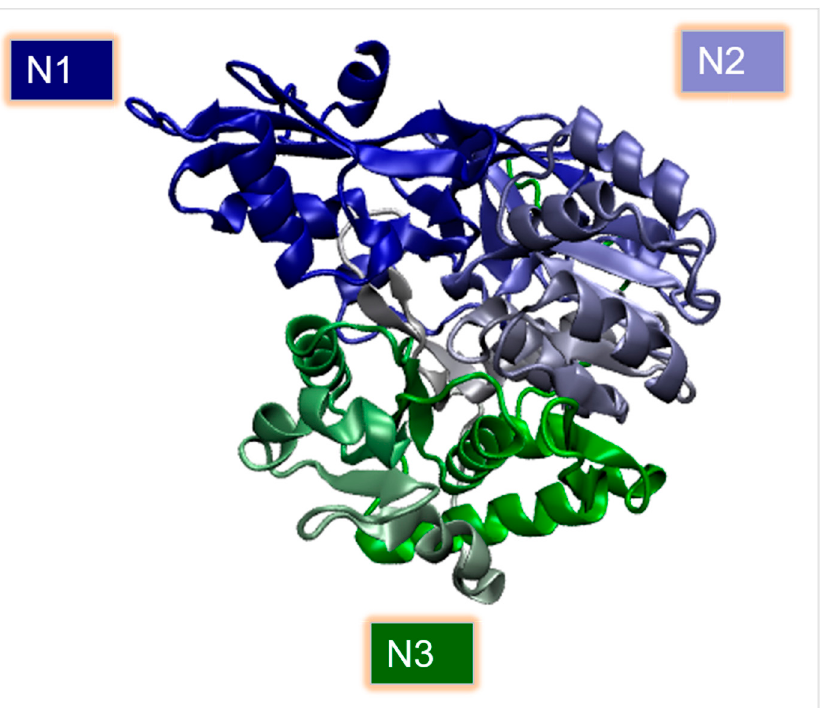
Figure 4. Crystal structure of carboxyl CoA ligase catalyzing branched chain fatty acid to branched chain acyl-CoA (PDB: 3NI2). The three subdomains of the N-domain, referred to as N1, N2, and N3, are colored blue, purple, and green, respectively.